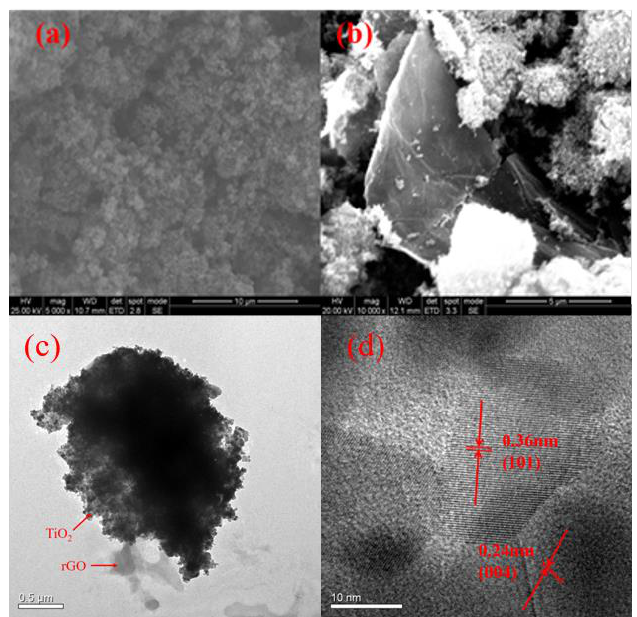
Figure 1. Scanning Electron Microscope (SEM) images of ( a ) pure P25; ( b ) 1% reduced graphene oxide- titanium dioxide photocatalyst (rGO – TiO 2 ) composite photocatalyst with ethanol as solvent; ( c ) TEM micrographs of 1% rGO – P25 and ( d ) HRTEM image of 1% rGO – P25.